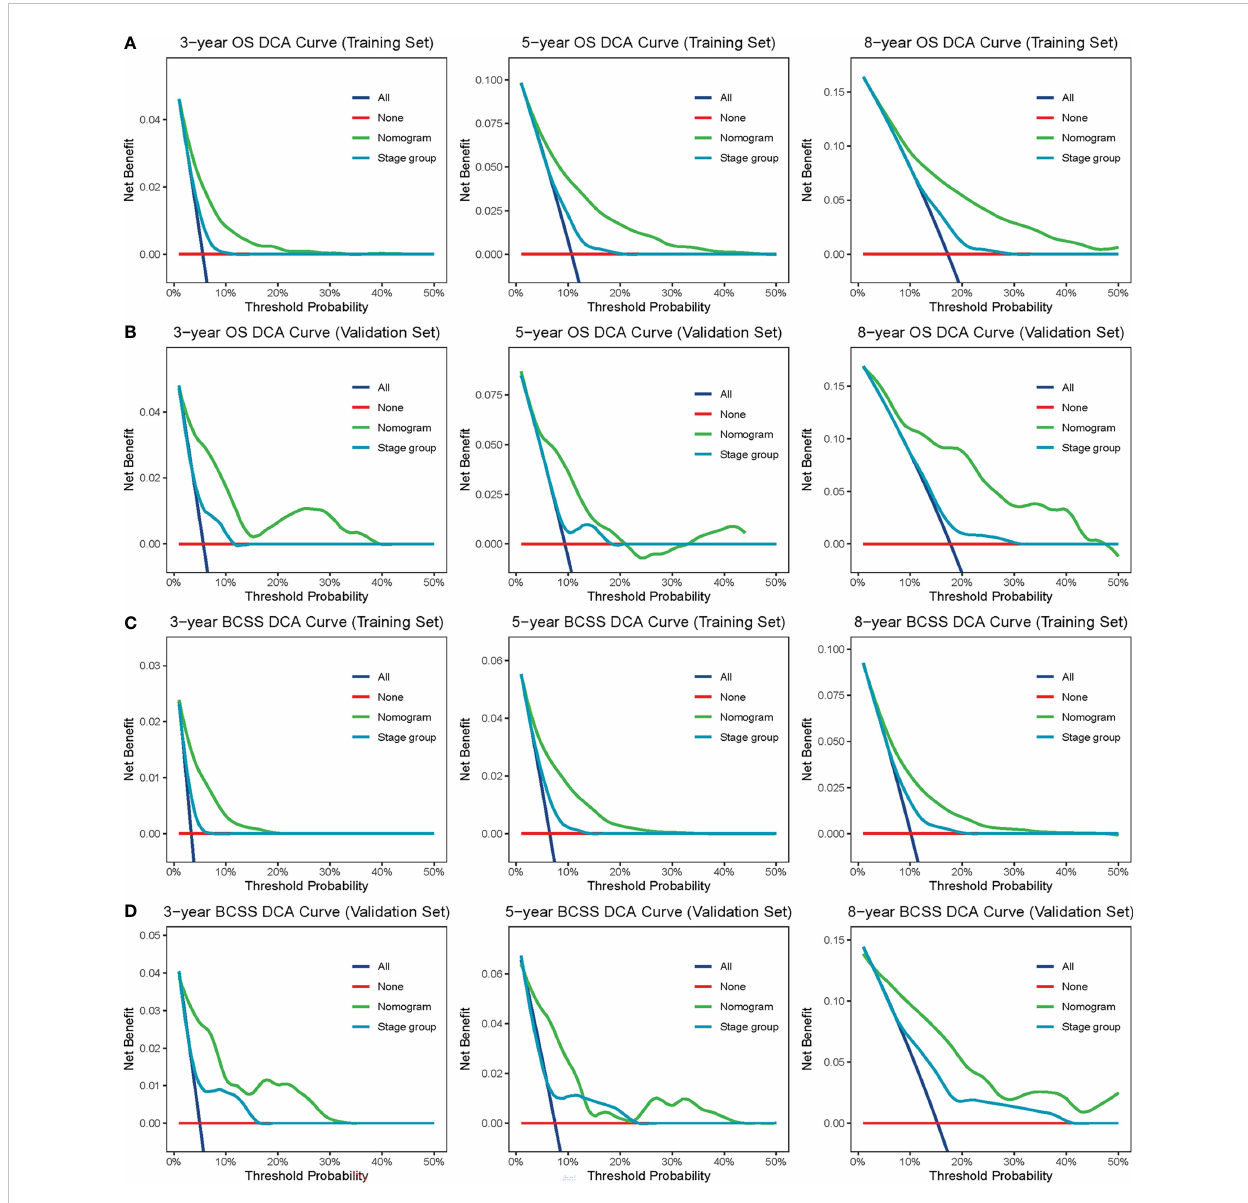
FIGURE 5 DCA curves. The DCA curves of nomogram and stage group (combination of the T stage and positive lymph nodes) in the training set (A, B) and validation set (C, D) were plotted based on 3-, 5-, and 8-year OS and BCSS, respectively. The green line represents nomogram, and the blue line represents stage group. DCA, decision curve analysis; OS, overall survival; BCSS, breast cancer-speci fi c